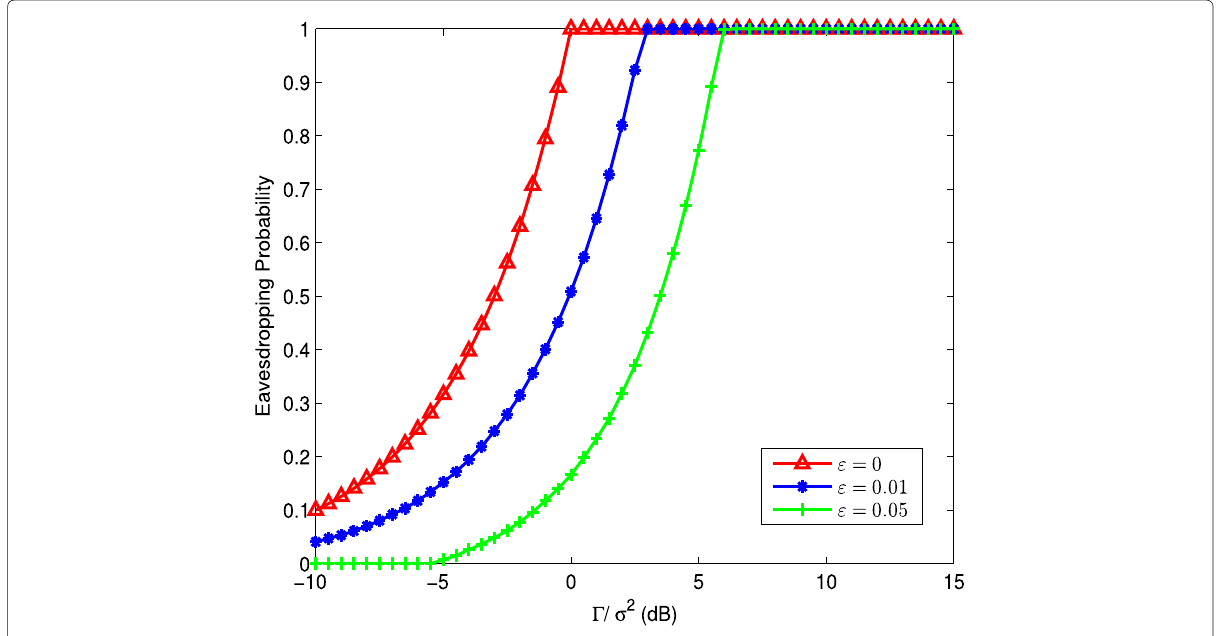
Fig. 5 Eavesdropping probability versus the interference temperature limit at